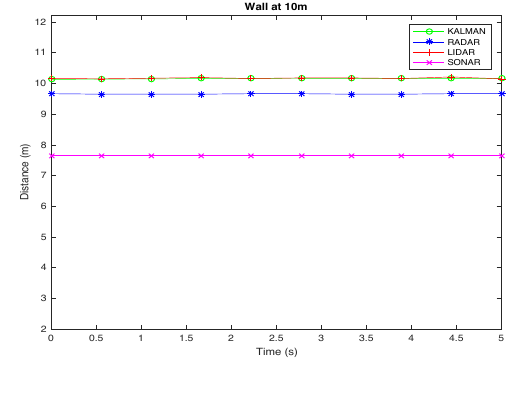
Figure 10. Wall at 10m